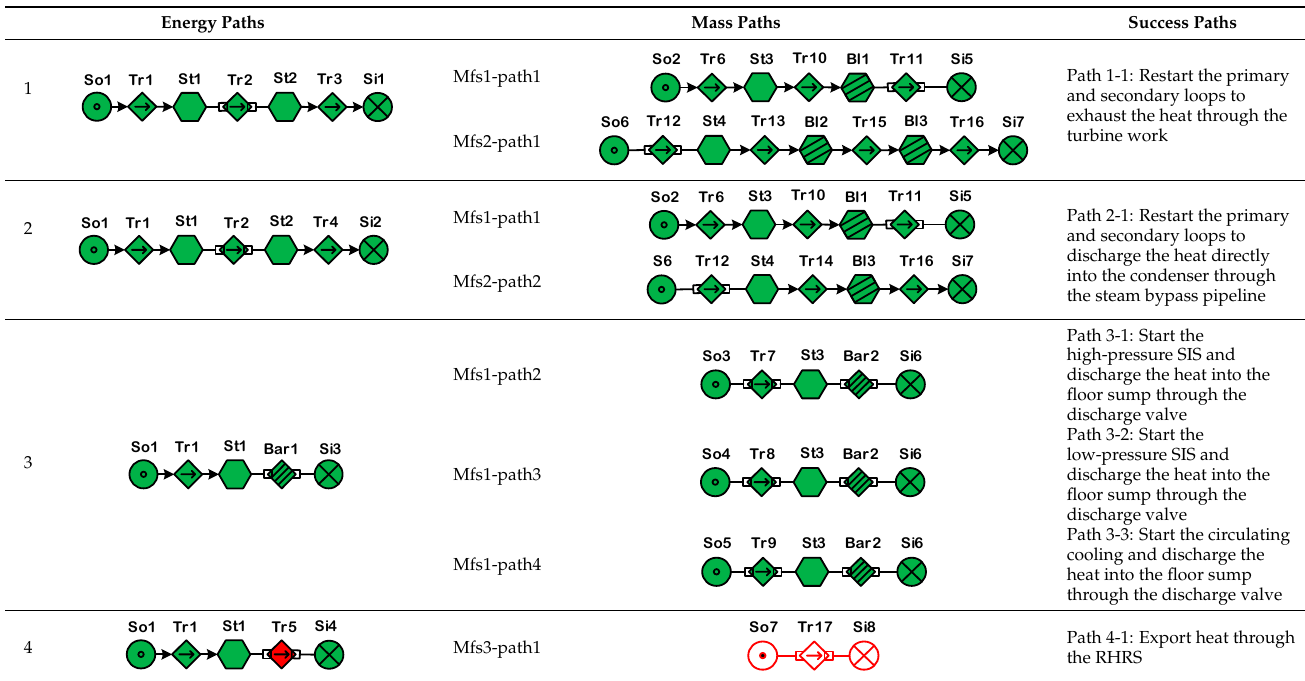
Table 4. Success paths identified after removing the paths with obvious hazard consequences.